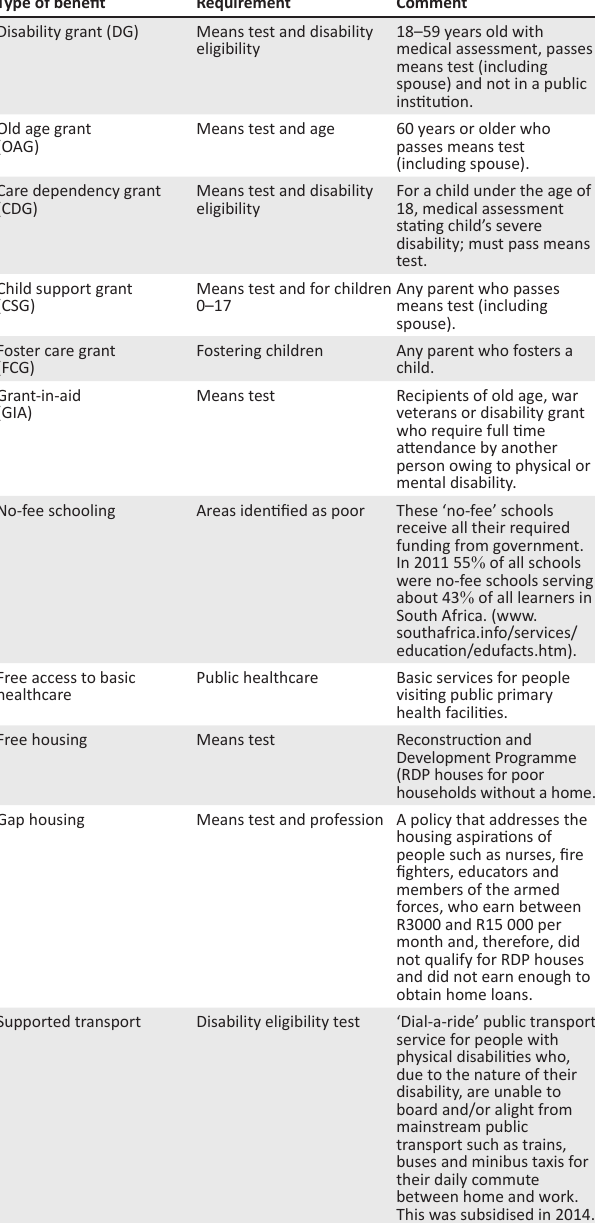
TABLE 1: Overview of current social protection mechanisms in South